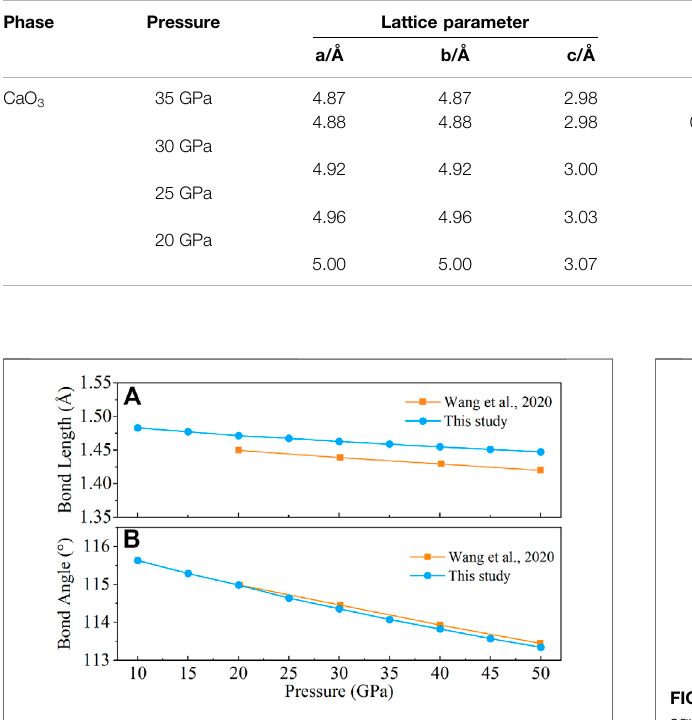
FIGURE 1 | Bond length (A) and bond angle (B) of the O – O – O bond under 0 – 50 GPa.